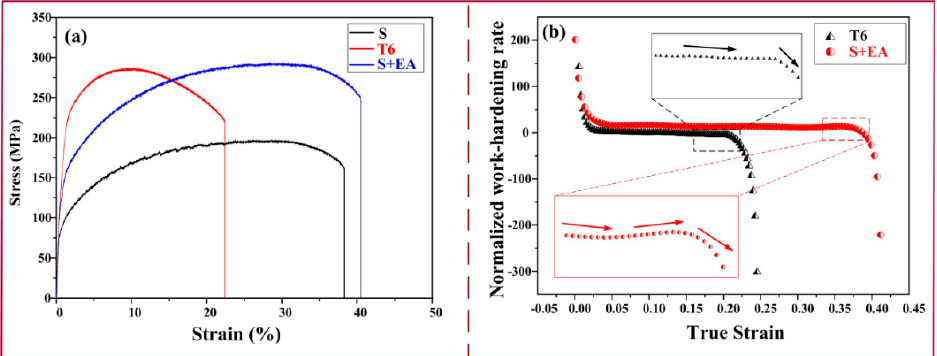
Figure 2. Properties of different samples: ( a ) Tensile properties and ( b ) normalized work-hardening rate curves. Table 2. The tensile properties of 6061 samples in different states.